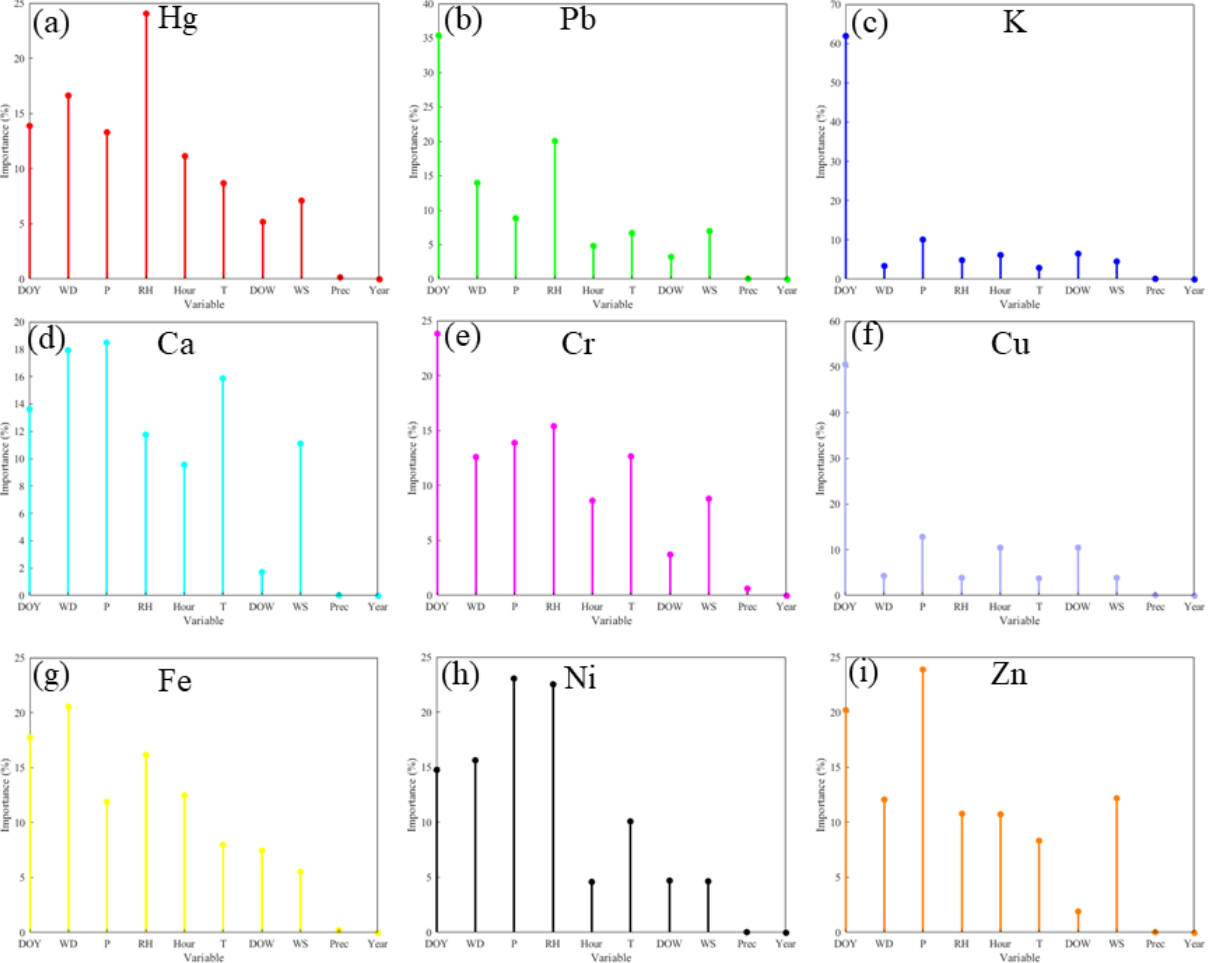
Figure 9. Relative importance of the predictors for the prediction of trace elements in PM 2 . 5 . The match in the figure denotes the variable importance in RF models for various species. DOY, WD, P , RH, Hour, T , DOW, WS, Prec, and Year represent day of year, wind direction, air pressure, relative humidity, hour of the day, air temperature, day of week, wind speed, precipitation, and study year.